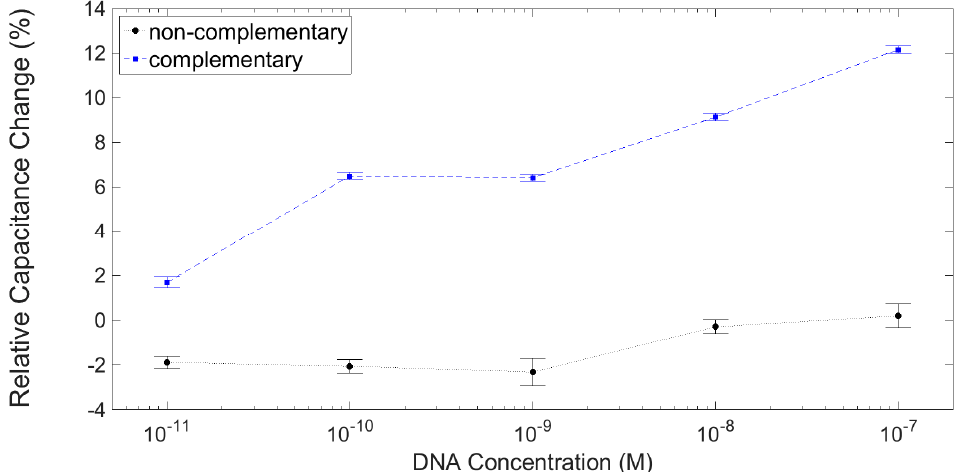
Figure 11. Dose response showing the relative change in capacitance from the ssPNA probe layer at 25 kHz for a device incubated with increasing concentrations of complementary ssDNA, and for a control device with increasing concentrations of complete mismatch non-complementary ssDNA. Error bars indicate ± σ , n = 5.